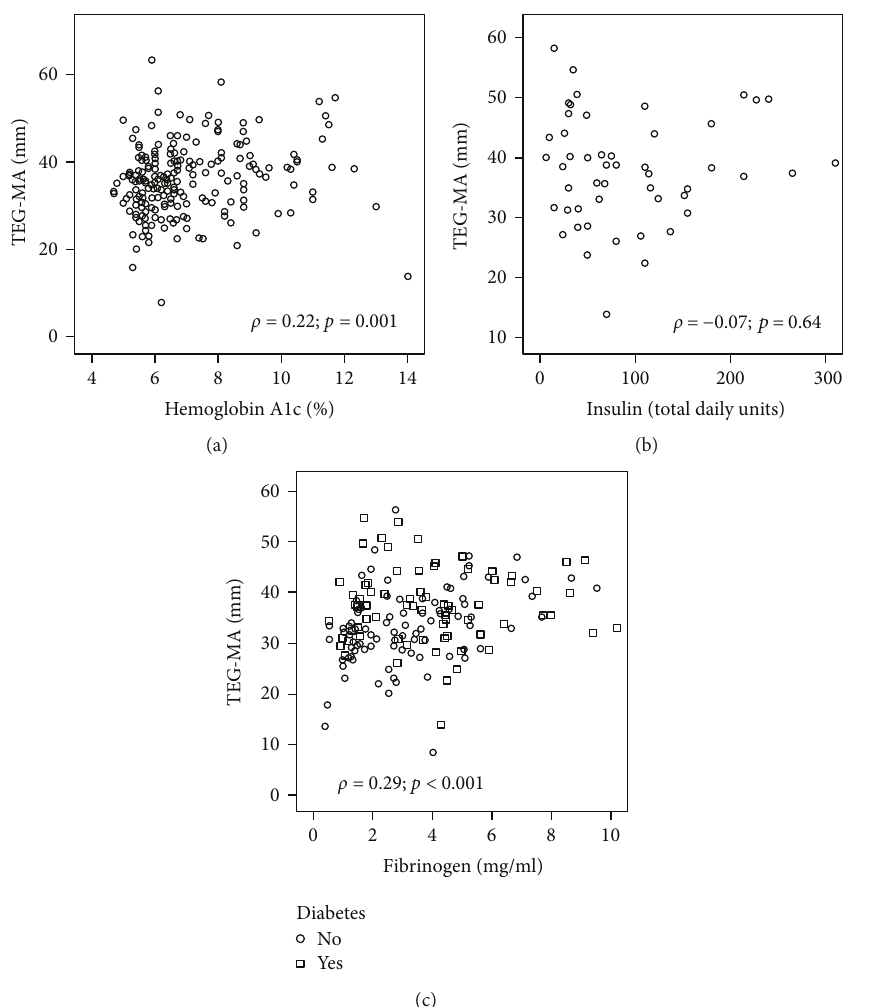
Figure 3: Scatterplot demonstrating maximal plasma fi brin clot strength (TEG-MA), hemoglobin A1c (a), insulin total daily dose (units) (b), and fi brinogen (c).